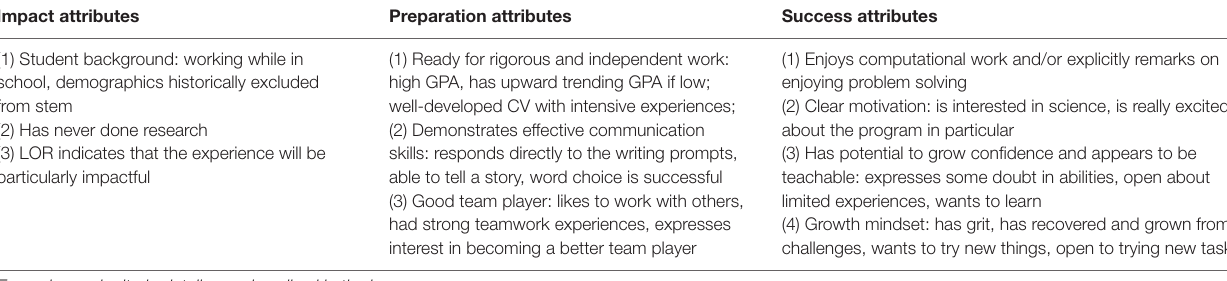
TABLE 1 | Applicant evaluation rubric summary of criteria under attribute categories: Impact, preparation, and success. Impact attributes